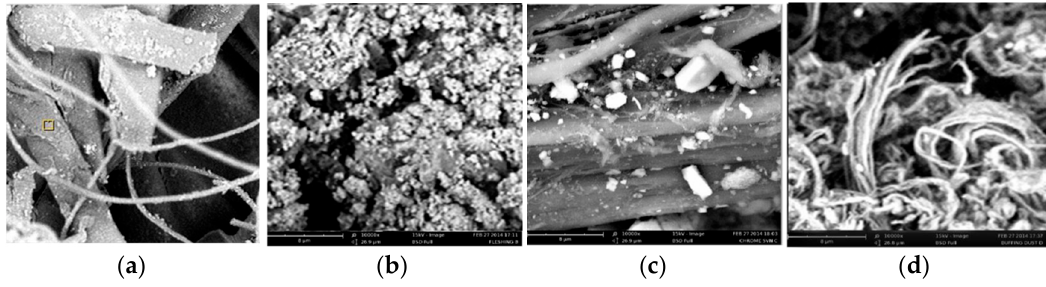
Figure 1. SEM Analysis Result of Pretreated Waste Samples at 15 kV × 10,000 Magnification. ( a ) HR; ( b ) FL; ( c ) CS; ( d ) BD.